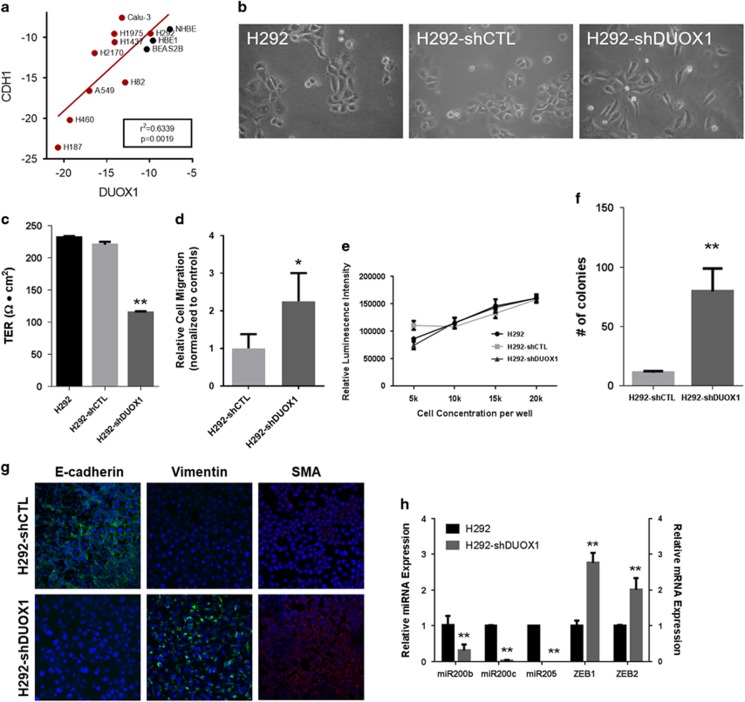
DUOX1 silencing displays functional mesenchymal features. (a) Evaluation of DUOX1 and E-cadherin (CDH1) mRNA expression in normal non-cancer airway epithelial cells (black dots) and a panel of lung cancer cell lines (red dots). (b) Phase contrast brightfield microscope images taken of host cell line H292, H292 cells transfected with an empty vector (H292-shCTL) and H292 cells transfected with short hairpin RNA targeted against DUOX1 (H292-shDUOX1). (c) Trans-epithelial resistance (Ω) characterization of each cell model. (d) Cell migration as measured by Donut cell migration assay. (e) Cells were seeded at various densities and allowed to grow in culture for 72 h. Post 72 h, cell viability via ATP production was determined in a luminescence assay. (f) Cells were grown on soft agar, and colonies counted to assess anchorage-independent growth. (g) Fluorescent images of EMT markers; SMA, smooth muscle actin. (h) Quantitative real-time PCR results of miR-200 family and transcriptional regulators of E-cadherin, ZEB1/2. *P<0.05 and **P<0.01 were calculated by Student's t-test.